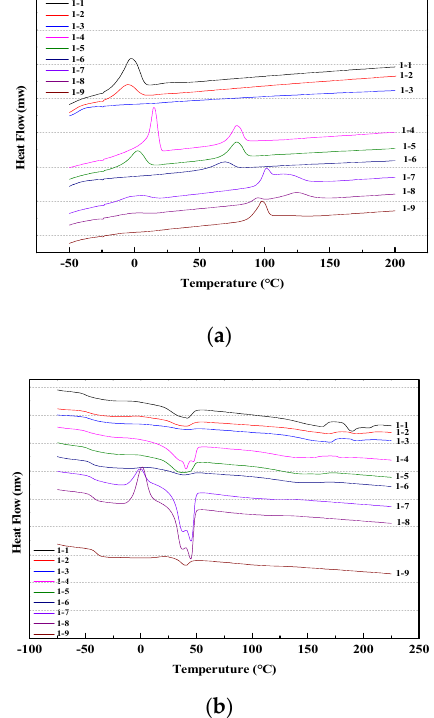
Figure 15. DSC curves shape of polyester-based TPUs. ( a ) Cooling curves; ( b ) Second heating curves. Materials 2020 , 13 , 4991